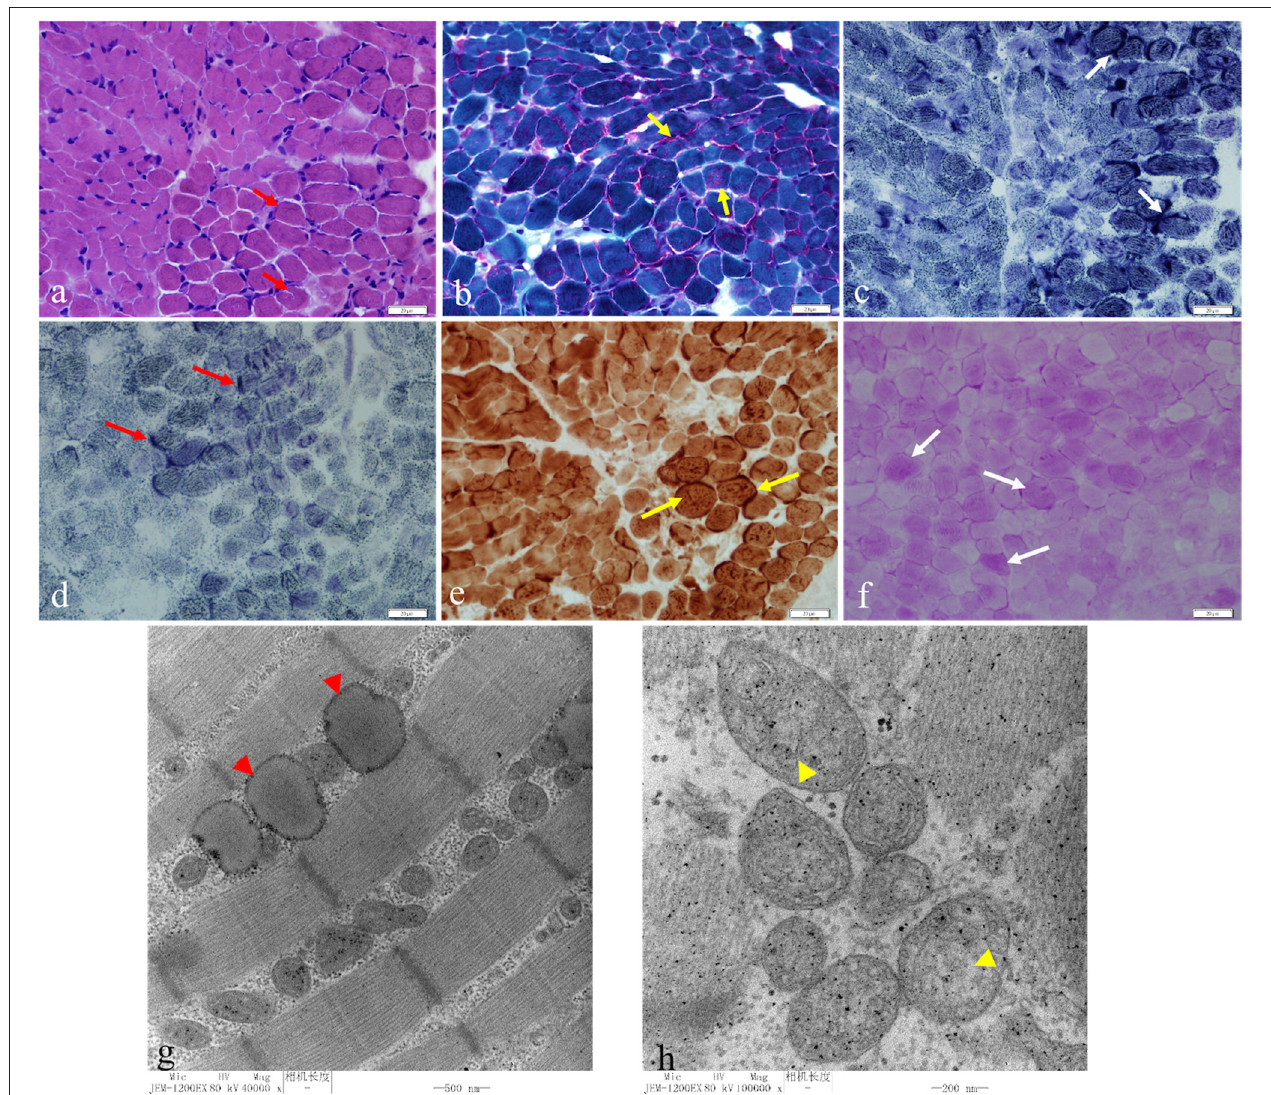
FIGURE 3 | HE staining showed that the muscle fibers were slightly different in size, and the small fibers were mostly small round and polygonal in shape. Cavitation and fissures were observed in the fibers with most fibers deeply staining the sarcolemma (a) (red short arrow, bar 20 µ m). Modified Gomeri tricolor (MGT) staining displayed a large number of muscle fibers showing cytoplasmic and sub-sarcolemma vacuole fissures with RRF-like changes (b) (yellow short arrow, bar 20 µ m). Deep staining was seen under the sarcolemma in many fibers in nicotinamide adenine dinucleotide (NAD) (c) (white short arrow, bar 20 µ m), succinate dehydrogenase (SDH) (d) (red long arrow, bar 20 µ m), cytochrome c oxidase (COX) staining (e) (yellow long arrow, bar 20 µ m). The glycogen content of a small number fibers increased significantly with periodic acid Schiff (PAS) staining (f) (white long arrow, bar 20 µ m). Transmission electron microscopy (TEM) showed an increased number of lipid droplets in many fibers (g) (red arrowhead, bar 500nm) and the mitochondria were abnormal with a severe loss of cristae (h) (yellow arrowhead, bar 200nm).